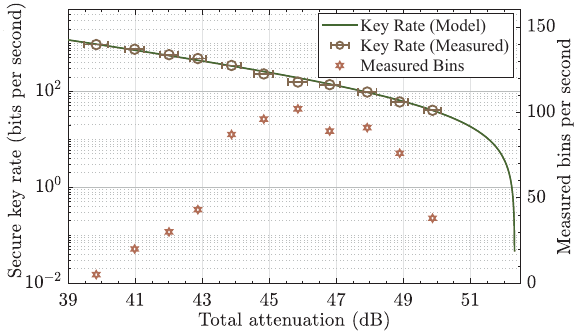
Fig. 4 Variation of the secure key rate as a result of atmospheric turbulence. Beam wander and beam spreading across the free- space link lead to a fl uctuating channel attenuation. This is quanti fi ed by binning a 148-s-long measurement in 100-ms intervals, in each of which the loss is computed via Eq. (2). The starlike data points correspond to the frequency of these bins, while the circular data points correspond to the average secure key rate within 1-dB loss-bins, where the horizontal error bars indicate the standard deviation of the corresponding average loss. The link is modeled according to Eq. (1) and the resulting rate is plotted (solid line). See Supplementary Table 2 for further